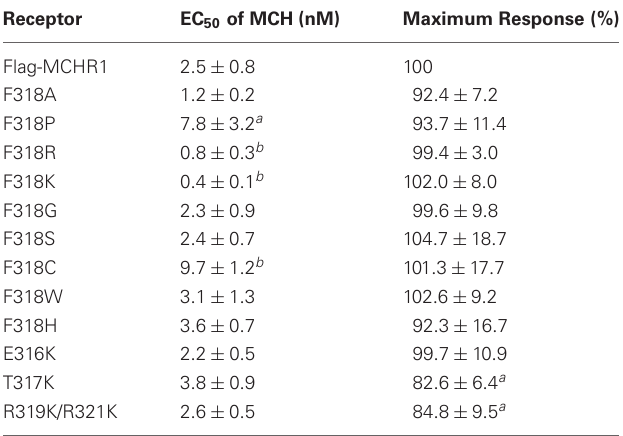
Table 3 | Calcium mobilization by MCH via Flag-MCHR1 and variants [containing single point mutations at F318 in the NPxxY(x) 5 , 6 F motif] expressed in HEK293T cells.